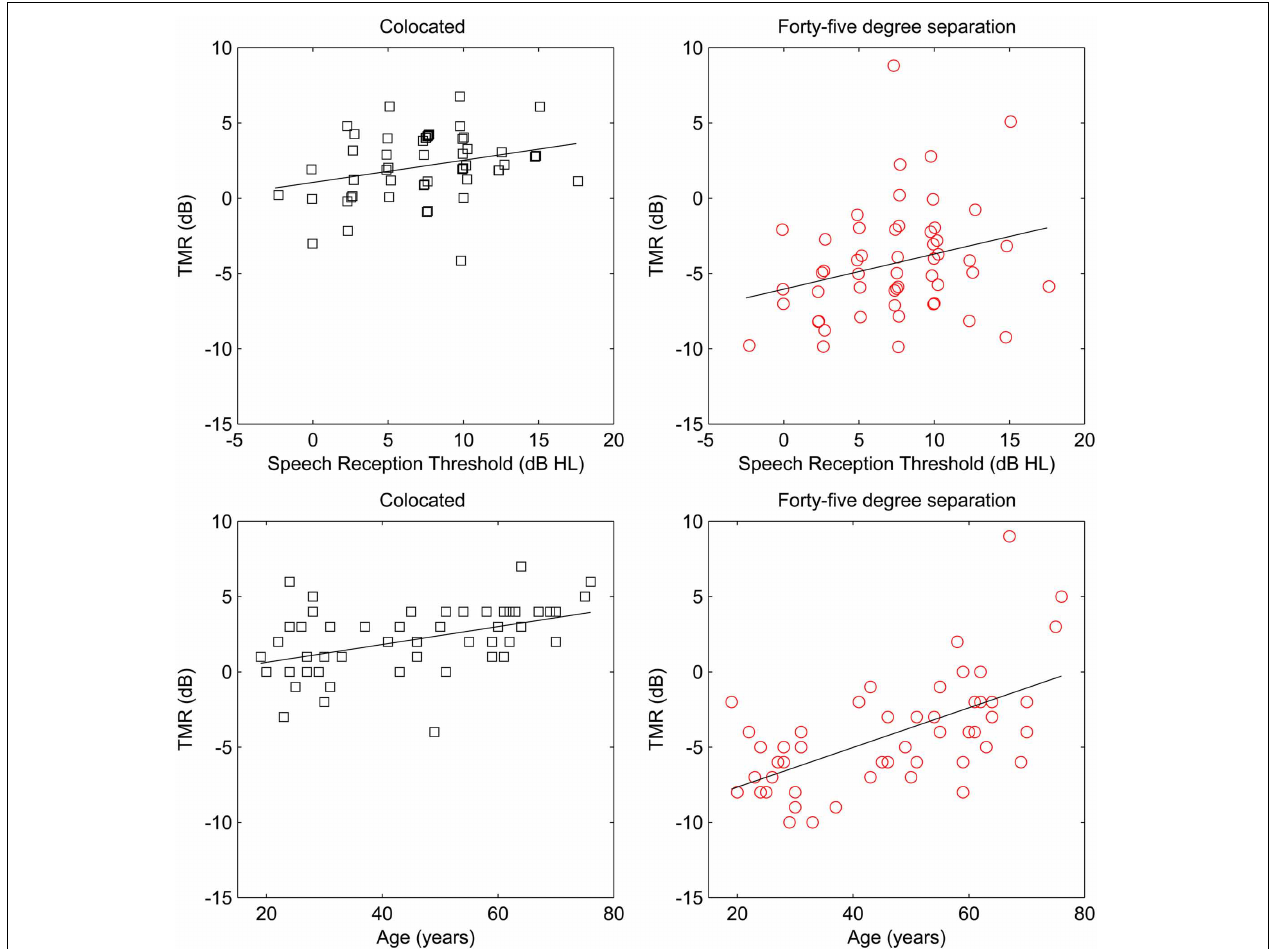
FIGURE 5 | Target-to-masker ratio (TMR) plotted as a function of speech reception threshold (SRT; top panels) and age (bottom panels) for the participants in Experiment Three. To further reduce testing time, only the same-gender maskers were tested. Although all targets and maskers were male, colocated target, and maskers (left